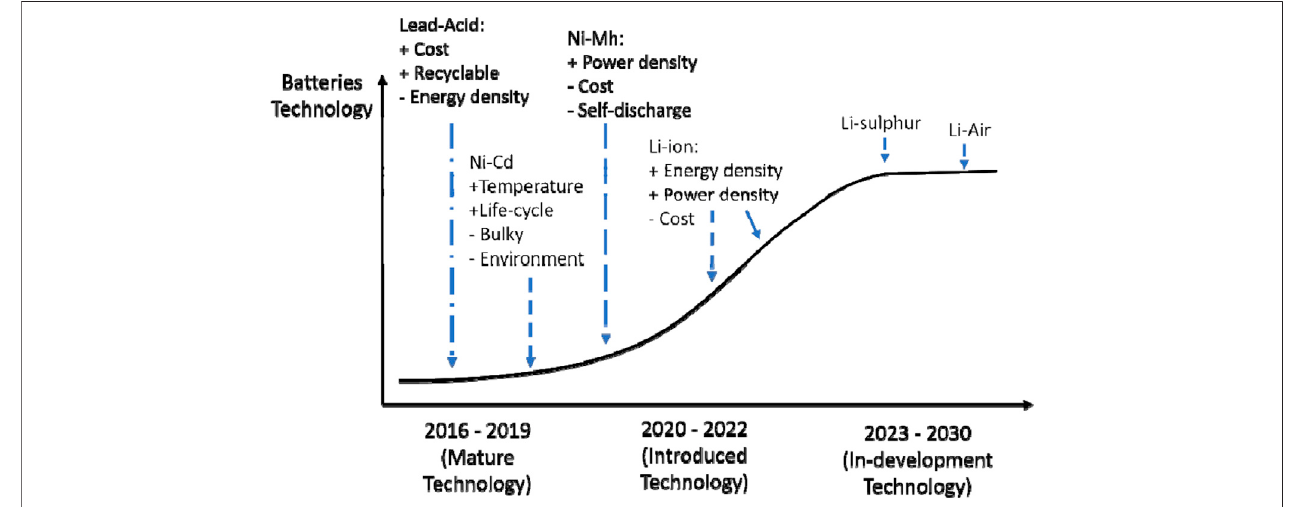
FIGURE 13 | Battery technology roadmap (Chalk and Miller, 2014).